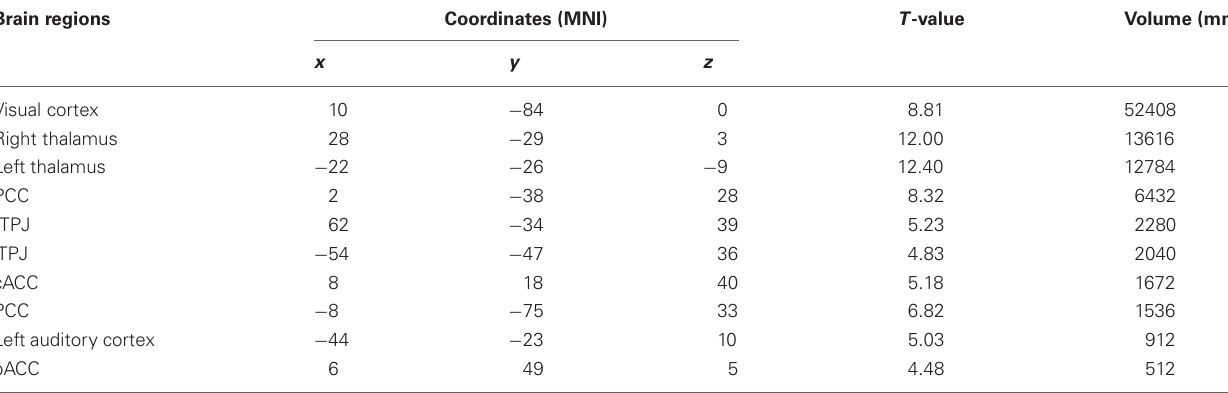
Table 1 | Activated clusters during EO > EC (Block design